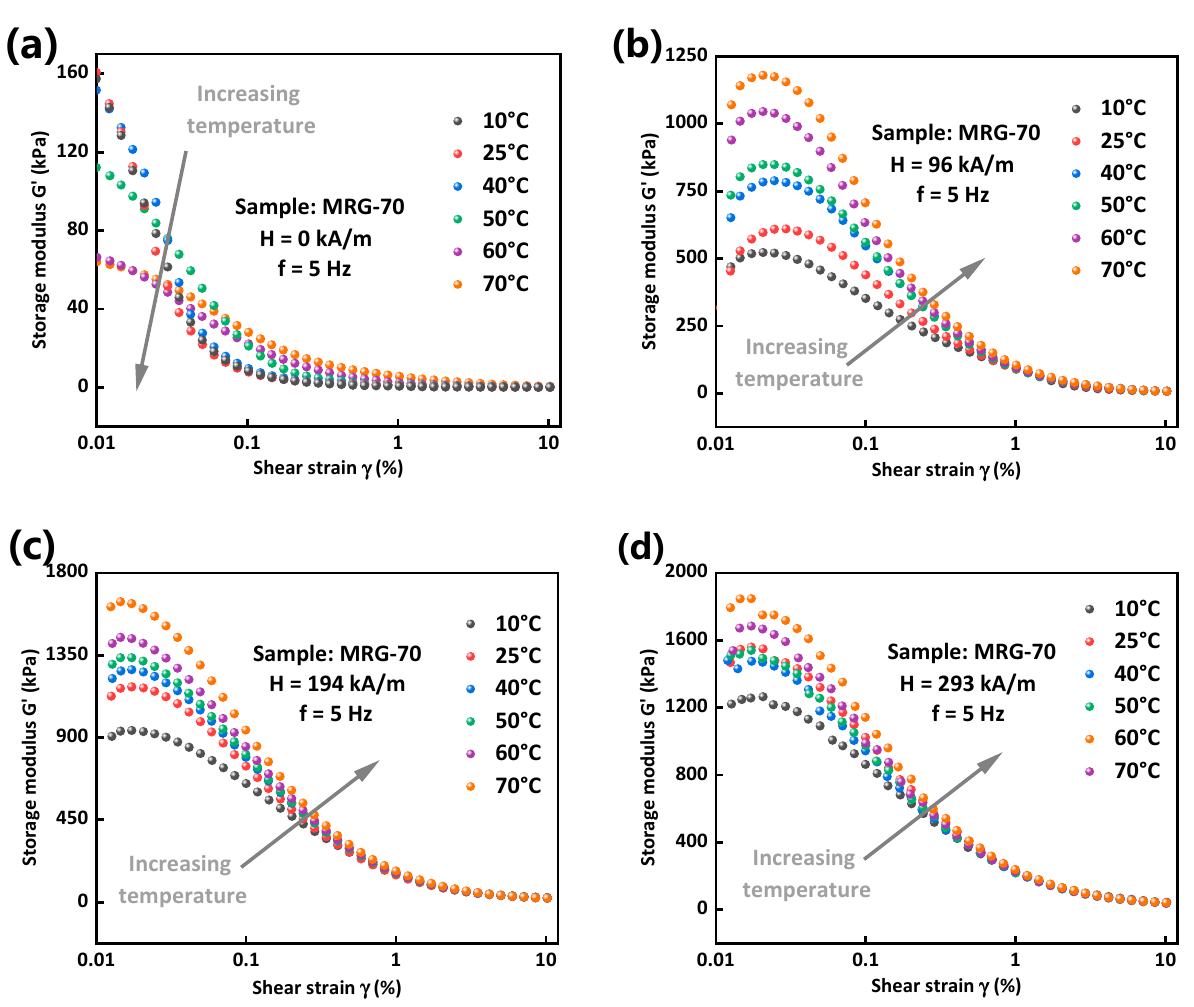
Figure 7. Storage modulus of MRG as a function of shear strain under different temperatures. 0 kA/m ( a ), 96 kA/m ( b ), 194 kA/m ( c ) and 293 kA/m ( d ).